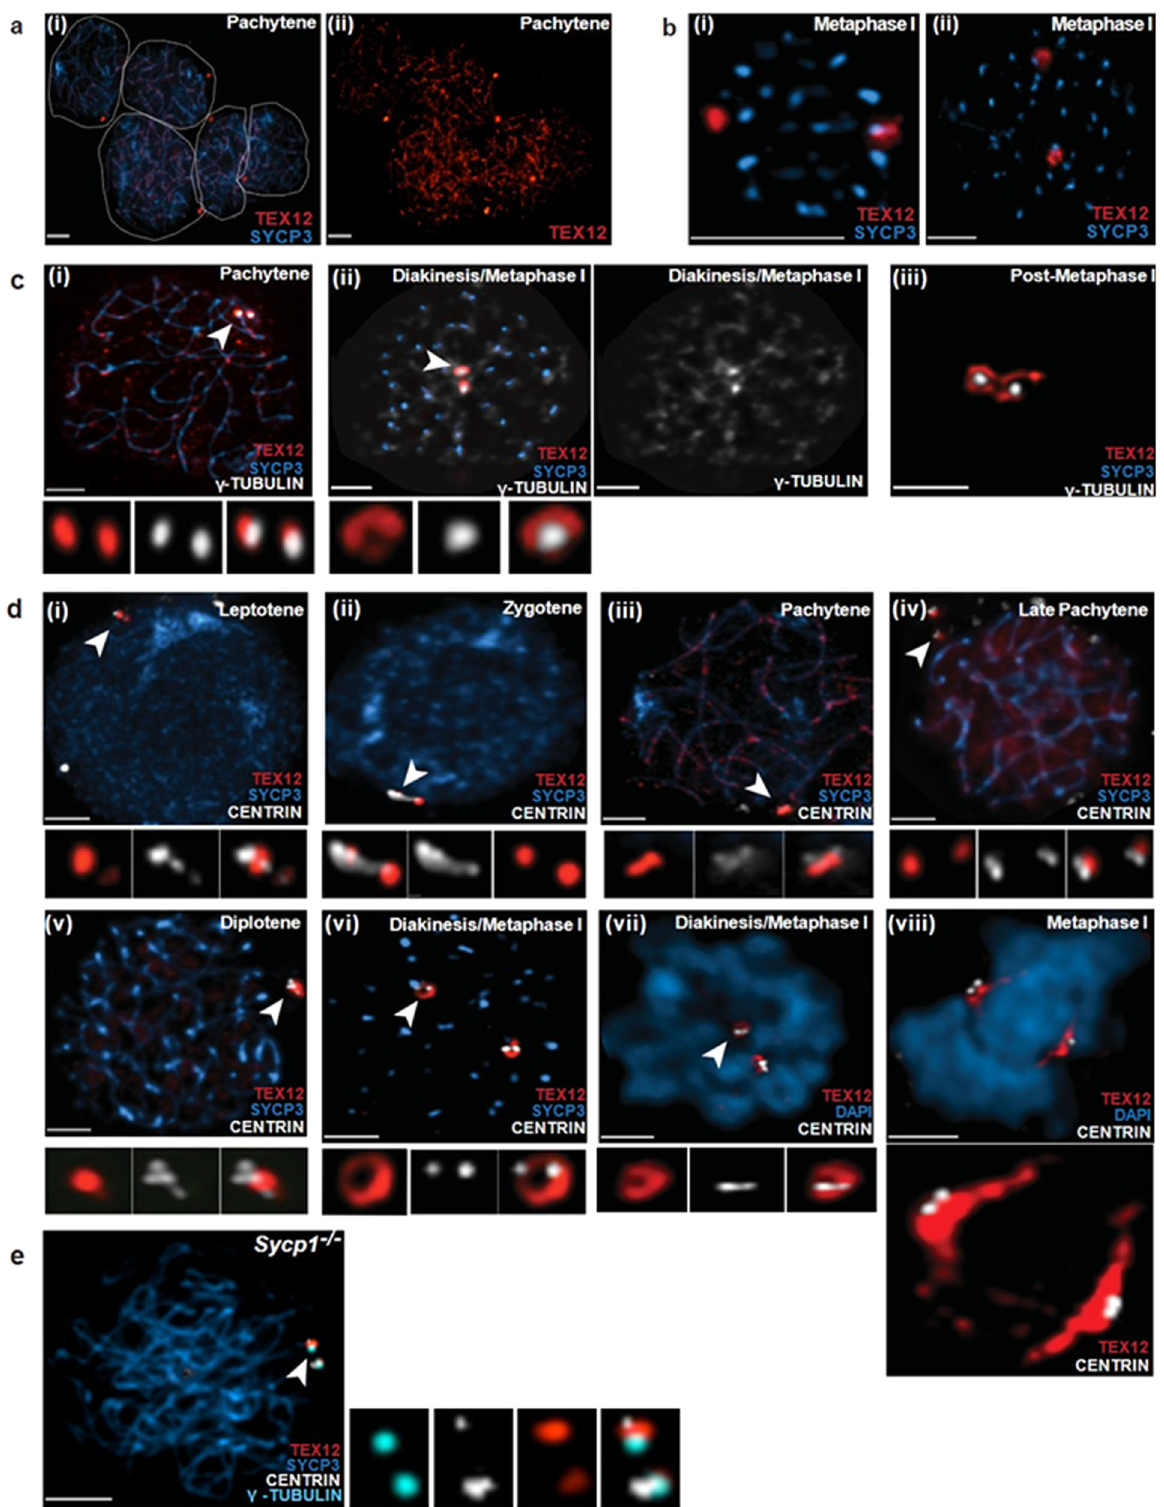
Fig. 2 TEX12 localises to centrosomes in mouse meiosis. a Pachytene-stage mouse spermatocyte immuno-stained for chromosome axis marker SYCP3 and TEX12. Individual nuclei are outlined. b Two views of metaphase-I nuclei with SYCP3 and TEX12 staining. c Spermatocyte nuclei at pachytene ( i ), diakinesis/metaphase-I ( ii ) and post-metaphase-I ( iii ), immuno-stained for SYCP3 (blue), TEX12 (red) and γ -Tubulin (white). Centrosomes are highlighted with arrowheads and magni fi ed in the lower panels. d Mouse spermatocytes immuno-stained for SYCP3 (blue), TEX12 (red), and centrosomal marker Centrin (white) ( i – vi ) or TEX12, Centrin (white) and DAPI (blue) ( vii – viii ). Individual centrosomes are highlighted with arrowheads and magni fi ed in the lower panels. For panel ( viii ), both TEX12-staining structures are magni fi ed below. e Spermatocyte nuclei from an Sycp1 mutant, immuno-stained for TEX12, Centrin, γ -Tubulin and SYCP3. Centrosome are highlighted with arrowhead and magni fi ed on side. All images are from squash preparations of mouse spermatocyte nuclei. Scale bar in all images, 10 µ